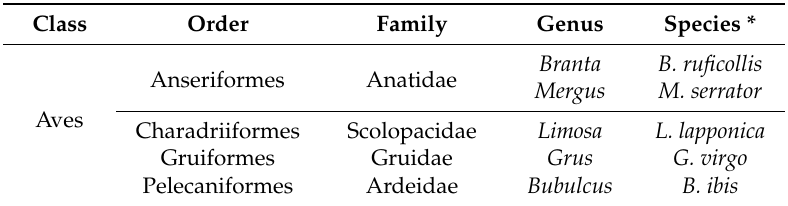
Table 9. List of mid-winter birds from the National Park of Urmia Lake [27].